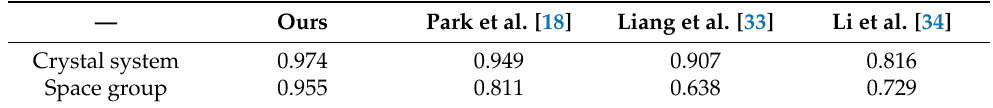
Table 6. Comparison of crystal structure recognition accuracy. — Ours Park et al. [18] Liang et al. [33] Li et al. [34] Crystal